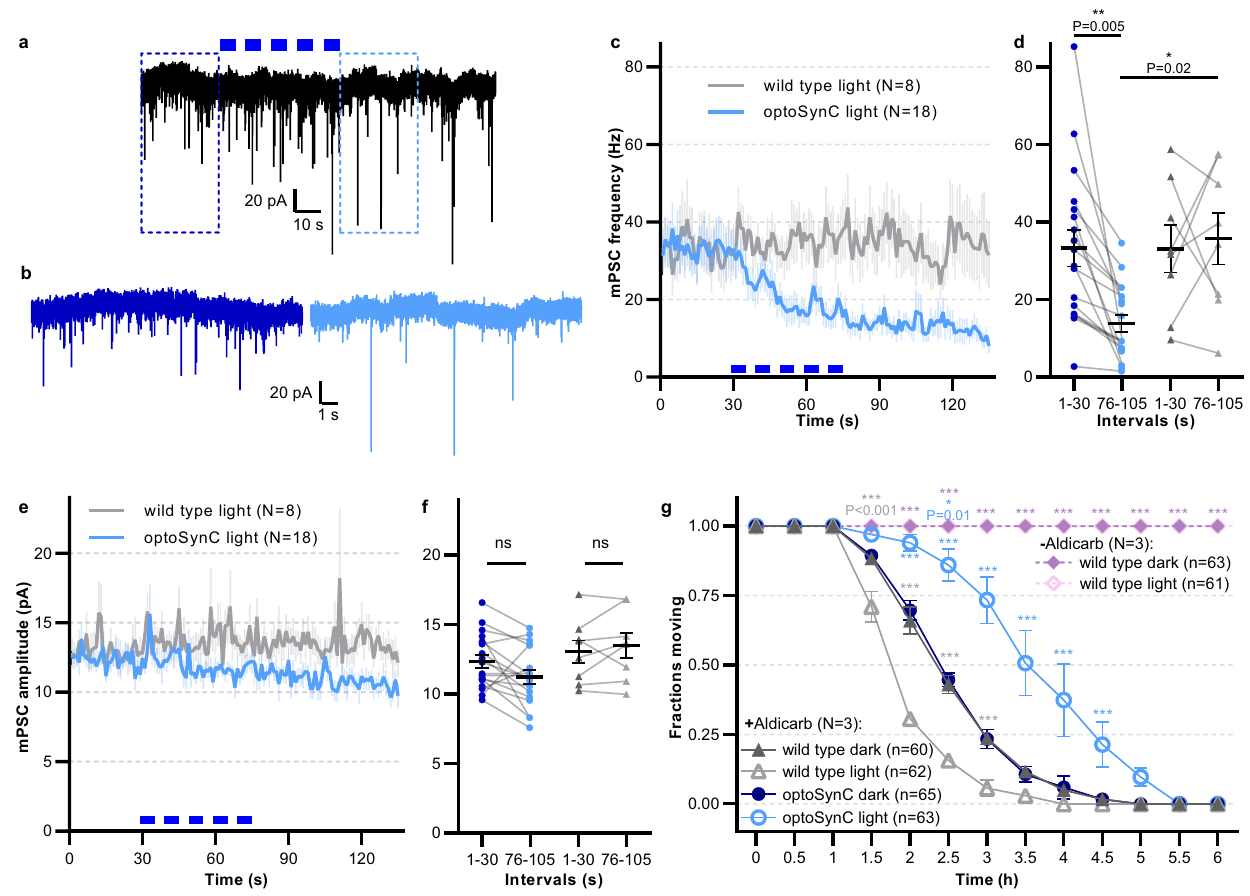
Fig. 3 | optoSynC activation reduces miniature post-synaptic current (mPSC) rate at the neuromuscular junction (NMJ) and can block cholinergic trans- missionfor hours.a Representative postsynaptic current traces recorded inbody wallmusclecellsofoptoSynC-expressinganimals;bluelightpulses(470nm,8mW/ mm², 5s / 5s ISI) indicated by blue rectangles. b Close-up of regions indicated in a , before (0 – 10s, dark blue) and after (95 – 105s, light blue) blue light illumination. c Mean (±s.e.m.) mPSC frequency with blue light illumination of wild type and optoSynC expressing animals. d Group analysis of data (mean±s.e.m.) in